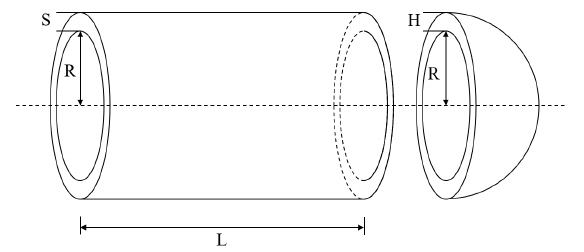
Figure 10. Pressure vessel design problem.